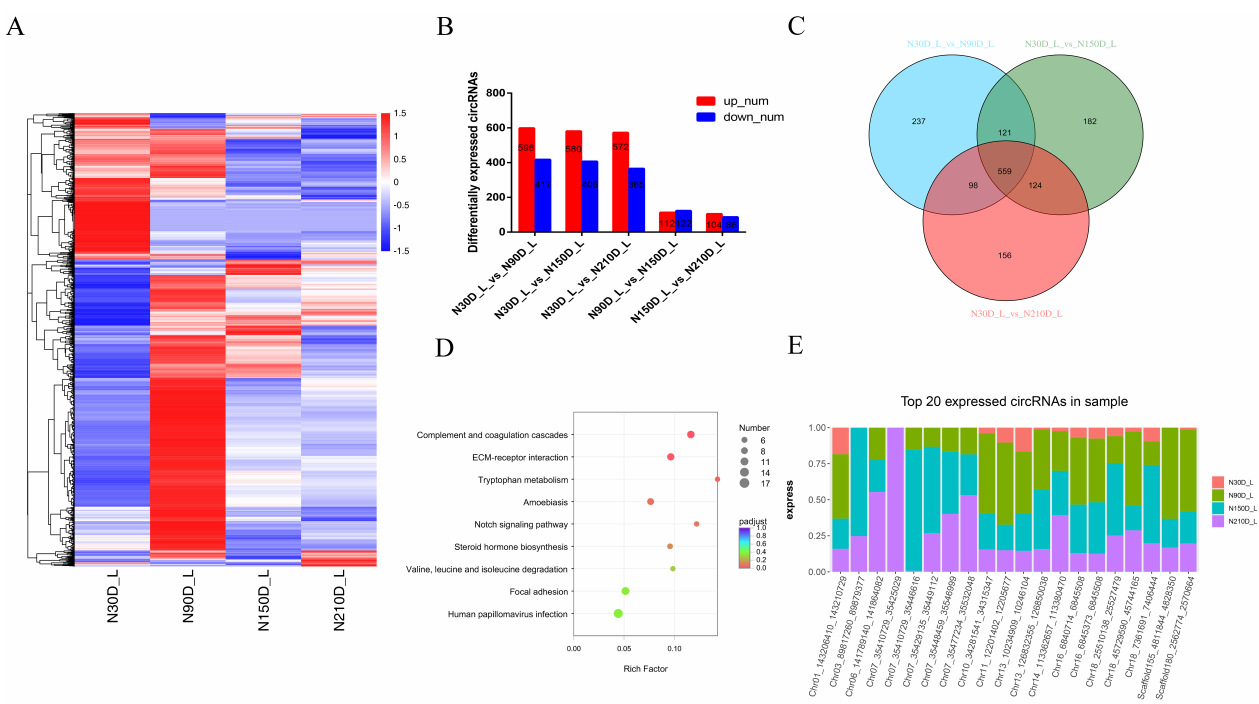
Figure 2. Differentially expressed (DE) circRNAs and their expression modes in liver: ( A ) heat map of all DE circRNAs among the five compared groups (30d vs. 90d, 30d vs. 150d, 30d vs. 210d, 90d vs. 150d, and 150d vs. 210d groups); ( B ) number of differentially expressed circRNAs in liver vs. means versus; ( C ) the number of common DE circRNAs in liver; ( D ) KEGG pathway analysis of common DE genes in liver. The top 10 enriched KEGG pathways ranked by p -values are shown; ( E ) top circRNAs expressed in liver.